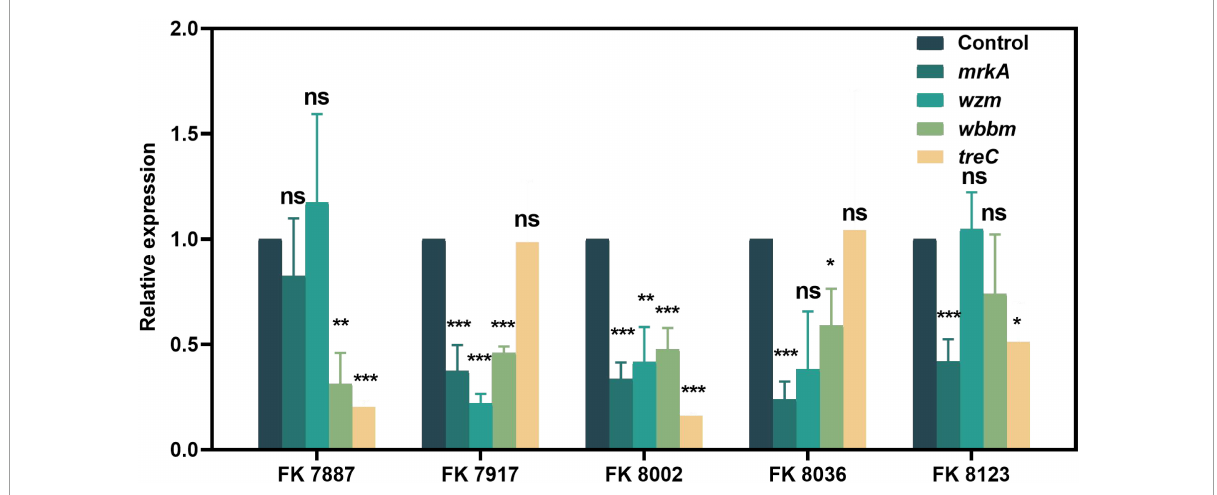
FIGURE11 The expression of biofilm formation genes of five carbapenem-resistant Klebsiella pneumoniae (CRKP) strains deal with different treatment groups. “*” Means P < 0.05, “**” means P < 0.01, “***” means P < 0.001, and “ns” means P > 0.05.